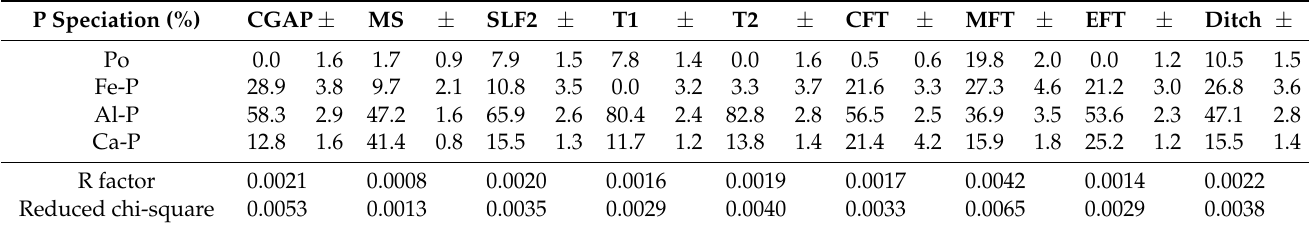
Table 3. Linear combination fitting (LCF) results as percentage of total P and the associated uncer- tainties, with the R-factor and reduced chi-square values indicating the goodness of the LCF results. The symbols on the left indicate phytic acid P (Po), P adsorbed to ferrihydrite (Fe-P), P adsorbed